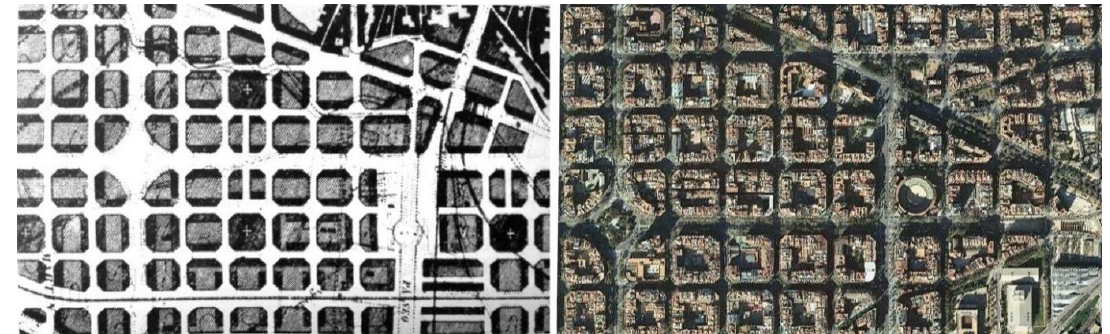
Figure 1. Comparison. ( Left ) Fragment of Cerdà’s original plan: block types and orientations [7]. ( Right ) Current state of Barcelona, where all sides and inside parts are built.